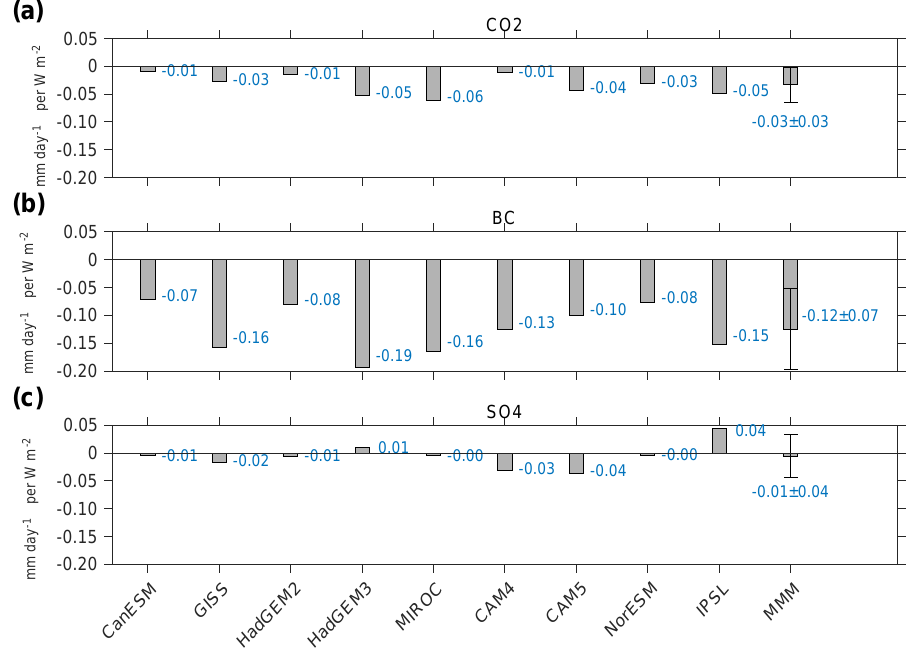
Figure 2. Domain-averaged (cid:49)P (purple rectangles in Fig. 1) for (a) CO 2 , (b) BC and (c) SO 4 . Error bars of multi-model mean (MMM) are 90% inter-model spread.